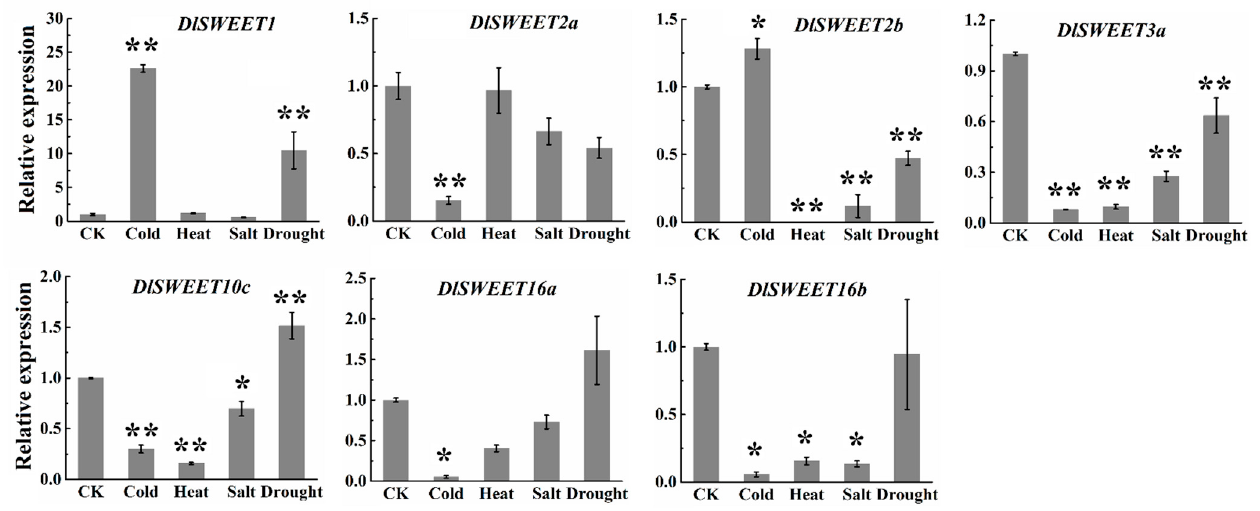
Figure 7. Expression analysis of the seven DlSWEET genes under various abiotic stress. Values presented as mean ± standard error (SE) ( n = 3). Small star above the bars indicate significant differences (* p ≤ 0.05, ** p ≤ 0.01).